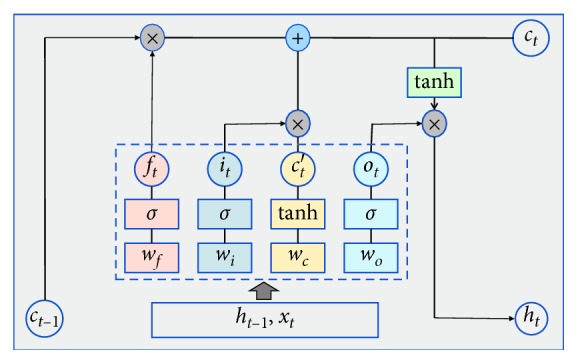
Framework of LSTM.